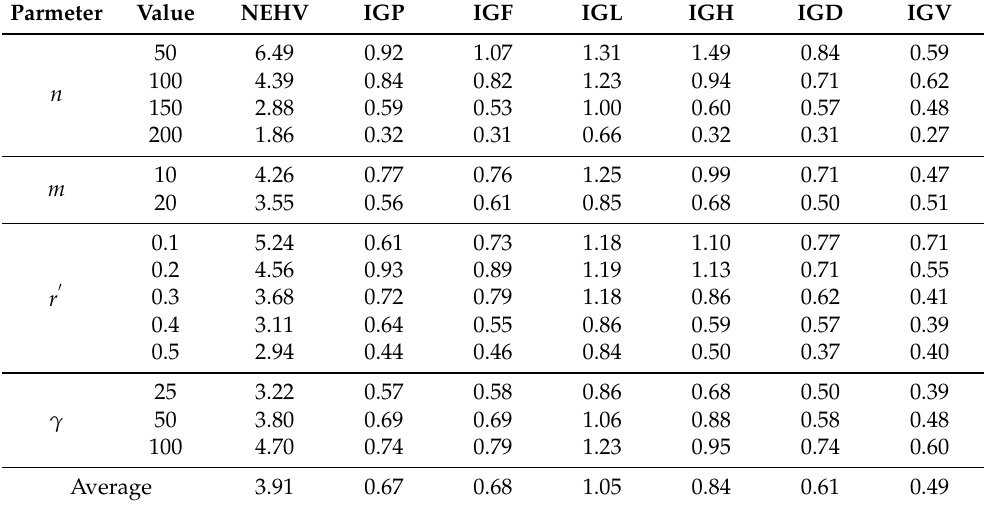
Table 12. Computational results for IGV: comparison with the most promising proposals in the